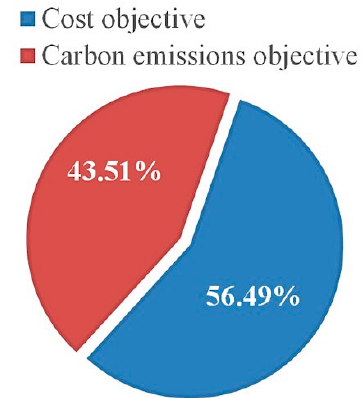
Figure 5. Contribution of satisfaction levels for the model with uncertain information.